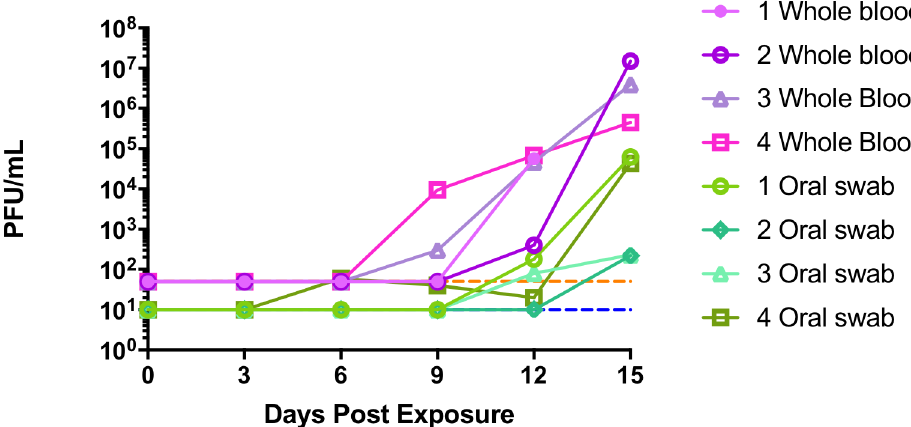
Skin lesions were present on two of the four animals (Fig 4). On animal #4, two focal pap- ules were observed on Day 12. By Day15 there were a total of nine lesions, seven of which had a hemorrhagic (petechial) appearance (Fig 4A and 4C) and two were scabbed (Fig 4B). Animal